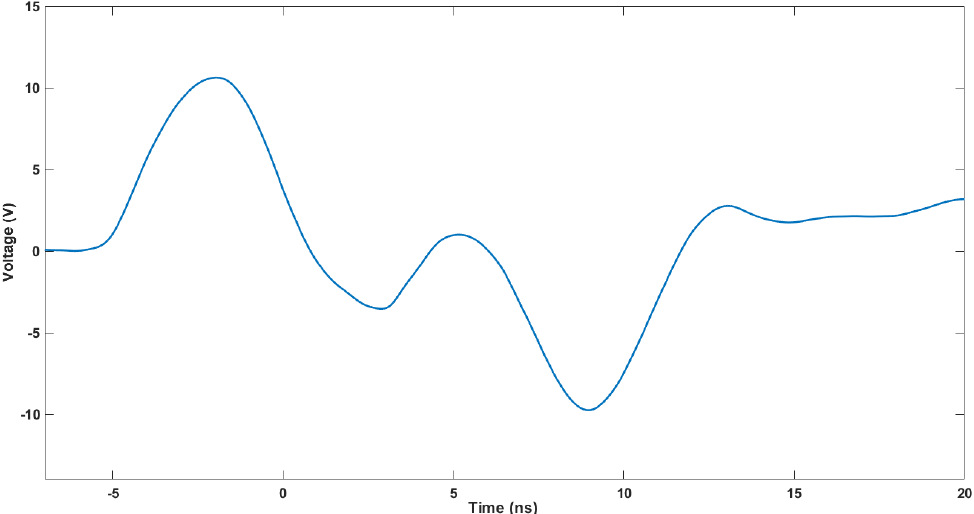
Figure 7. Electrical pulse measured with a 405 nm LED, supplied at 30 V with a frequency of 1 kHz. The negative after pulse, created by the inductor in parallel with the LED, helps to decrease the duration of the optical